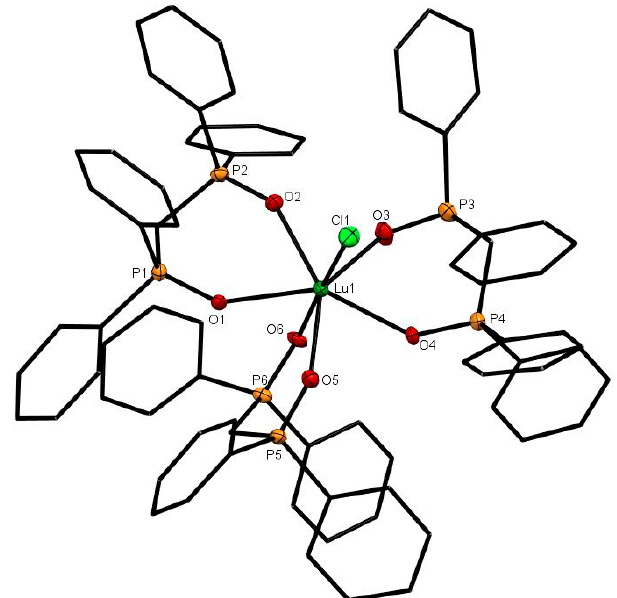
Figure 6. The X-ray structure of [Lu(dppmO 2 ) 3 Cl]Cl 2 . The chloride anions and solvate molecules are omitted. Selected bond lengths (Å) and angles (°): Lu1–Cl1 = 2.5604(7), Lu1–O1 = 2.341(5), Lu1–O2 = 2.268(5), Lu1–O3 = 2.268(5), Lu1–O4 = 2.297(5), Lu1–O5 = 2.354(5), Lu1–O6 = 2.227(5), P–O = 1.497(5)-1.510(5), Cl1–Lu1–O6 =